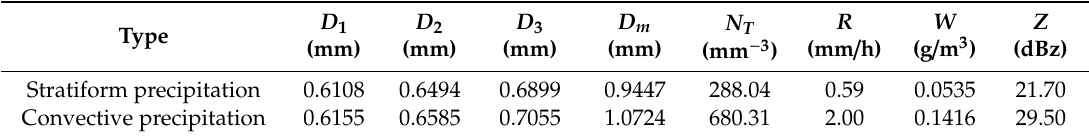
Table 4. The mean values of microphysical parameters. Note: D 1 (mean diameter), D 2 (root mean square diameter), D 3 (root mean cube diameter), N T (total raindrop concentration), R (rainfall intensity), W (liquid water content), Z (radar reflectivity